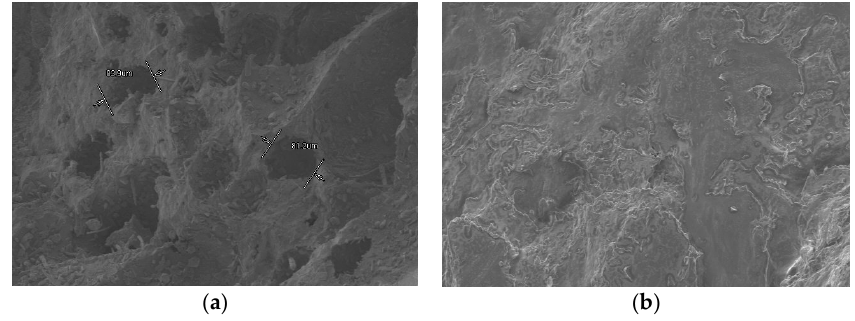
Figure 6. SEM pictures of the float stones and composite PCM: ( a ) float stones; and ( b ) float stones immersed by PCM.